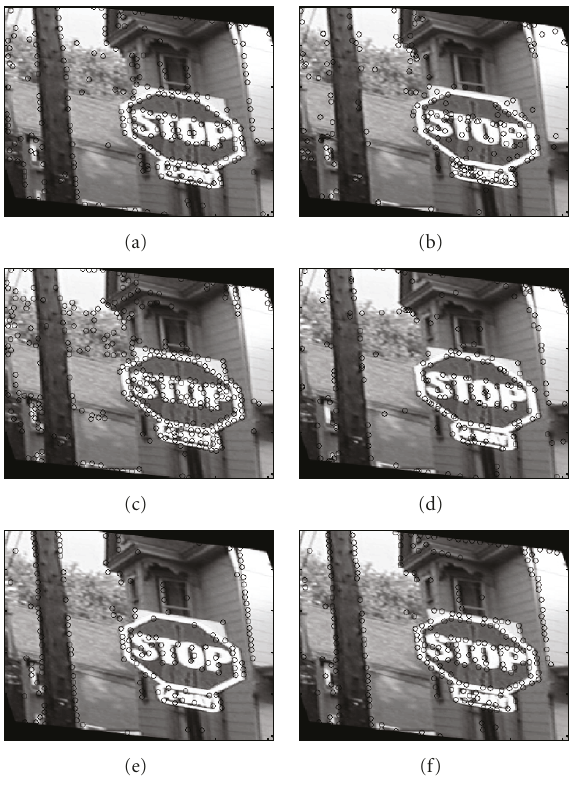
Figure 11: Feature points detected in sheared image by (a) Harris method (b) Lowe’s method, (c) Tomasi’s method, (d) Loupias’s technique, (e) Yeh’s algorithm, and (f) proposed technique.